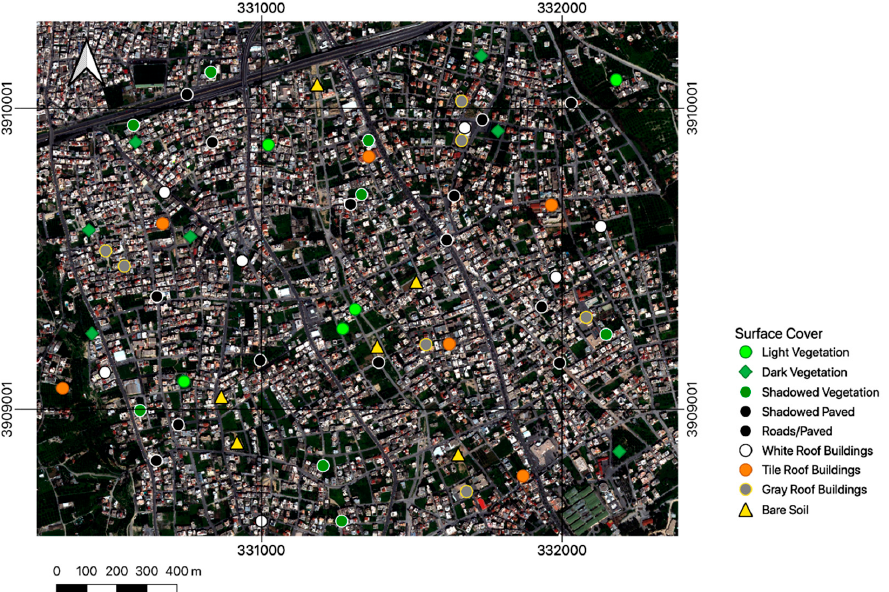
Figure 3. Indicative sampling points used in classifier training in the vicinity of the intervention area.